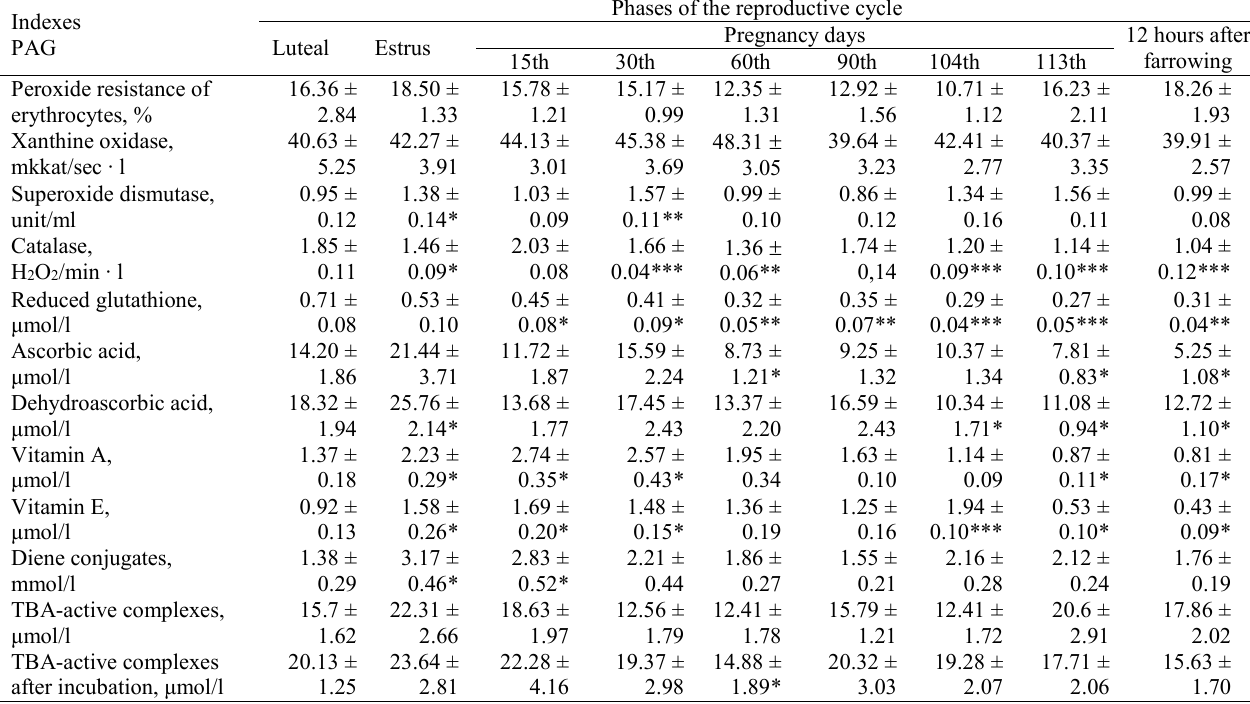
The state of PAG in blood of the Red White-belted breed of meat gilts during the reproductive cycle, M ± m (n =